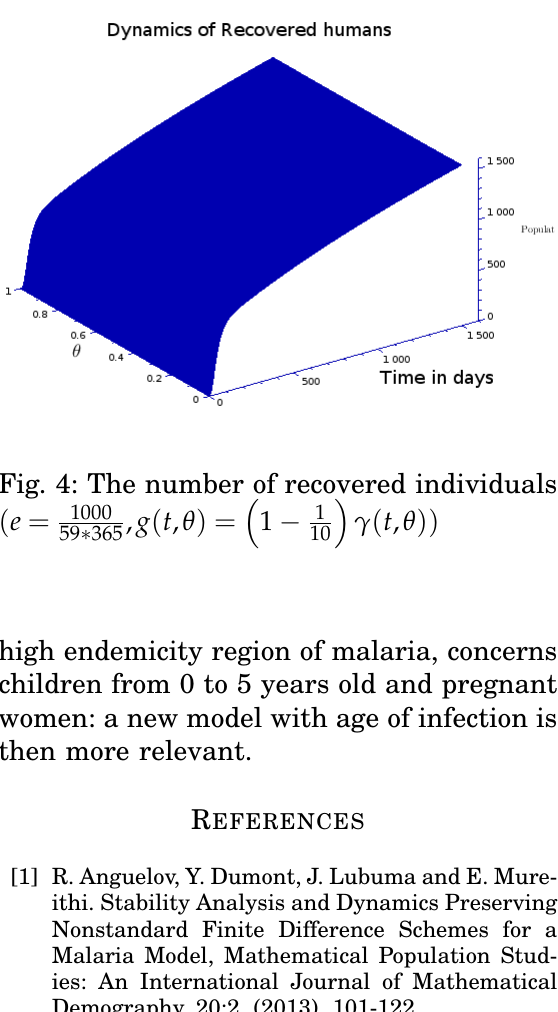
high endemicity region of malaria, concerns children from 0 to 5 years old and pregnant women: a new model with age of infection is then more relevant. R